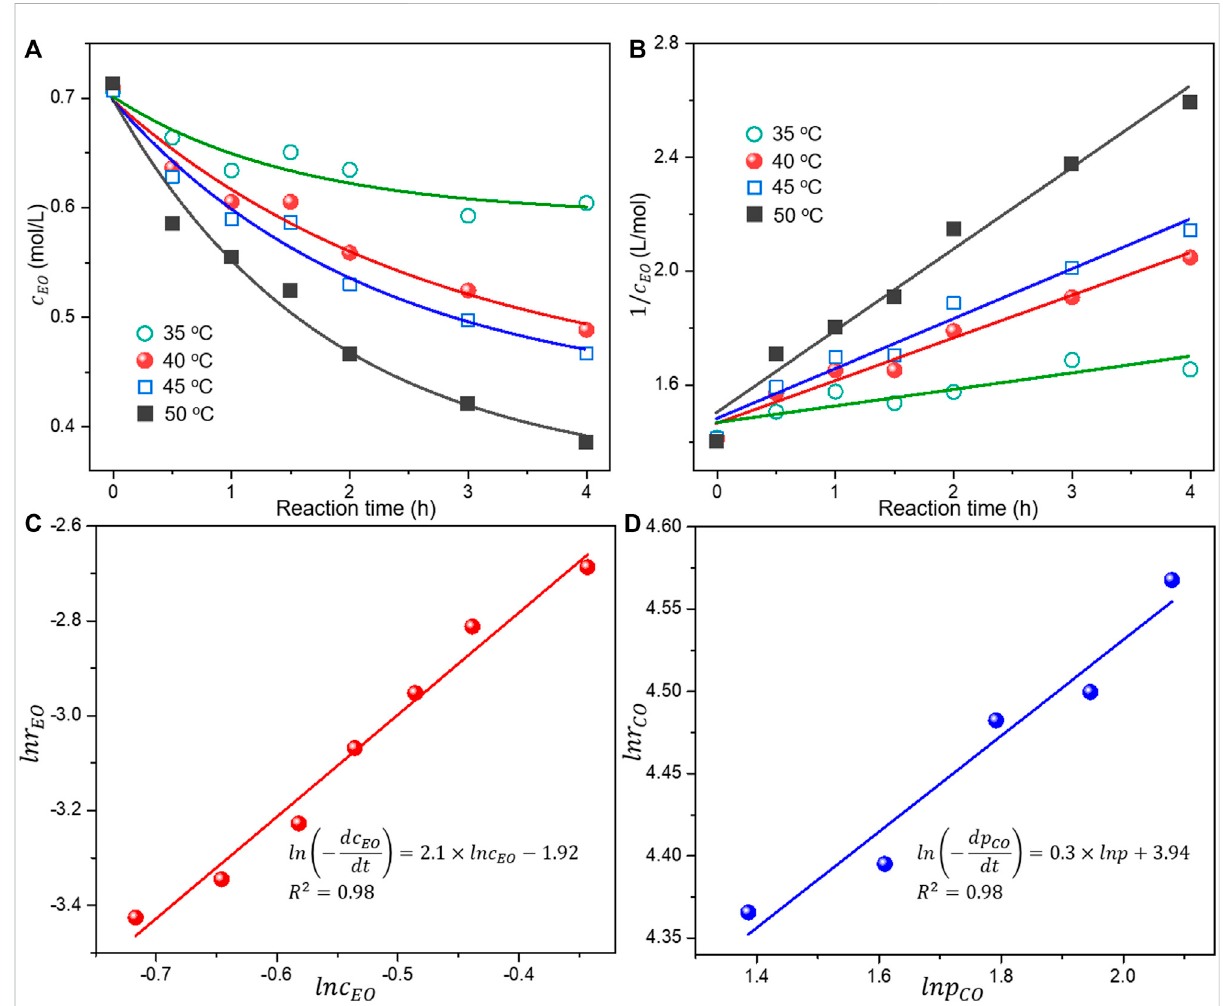
FIGURE 2 (A) Reaction data of the EO concentration at different reaction time and temperature, (B) linear relationship between 1/ c EO and reaction time according to the second-order reaction kinetics, (C) linear relationship between lnr EO and lnc EO at 40 ° C of the EO carbonylation, and (D)